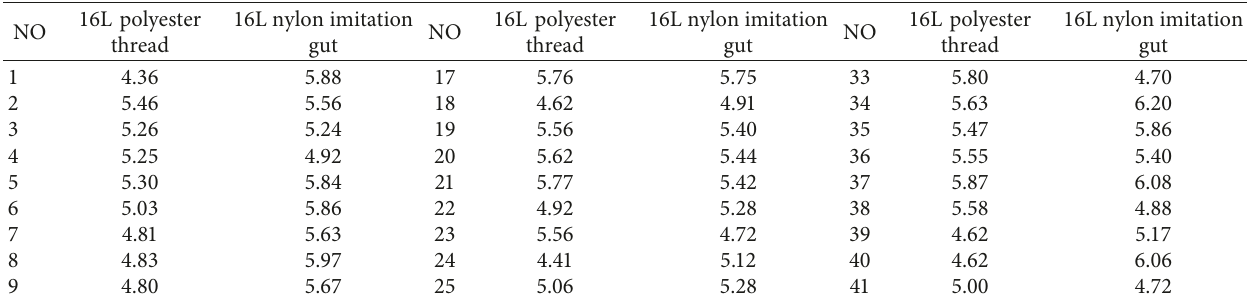
Table 4: Swing vibration frequency of different material groups.